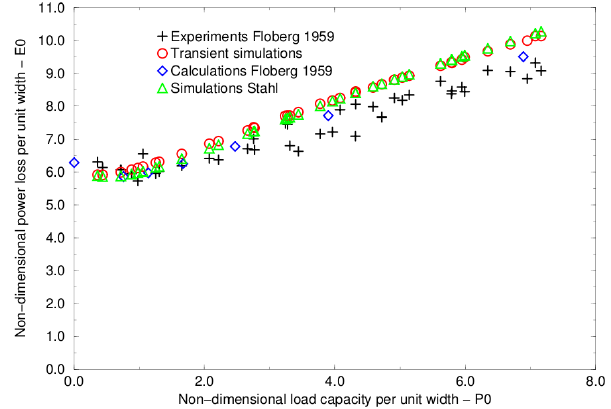
Figure 10: Power loss; simulations, and experiments (Floberg, 1959). This for 360 ◦ journal bear- ing with oil groove at 90 ◦ before the load.